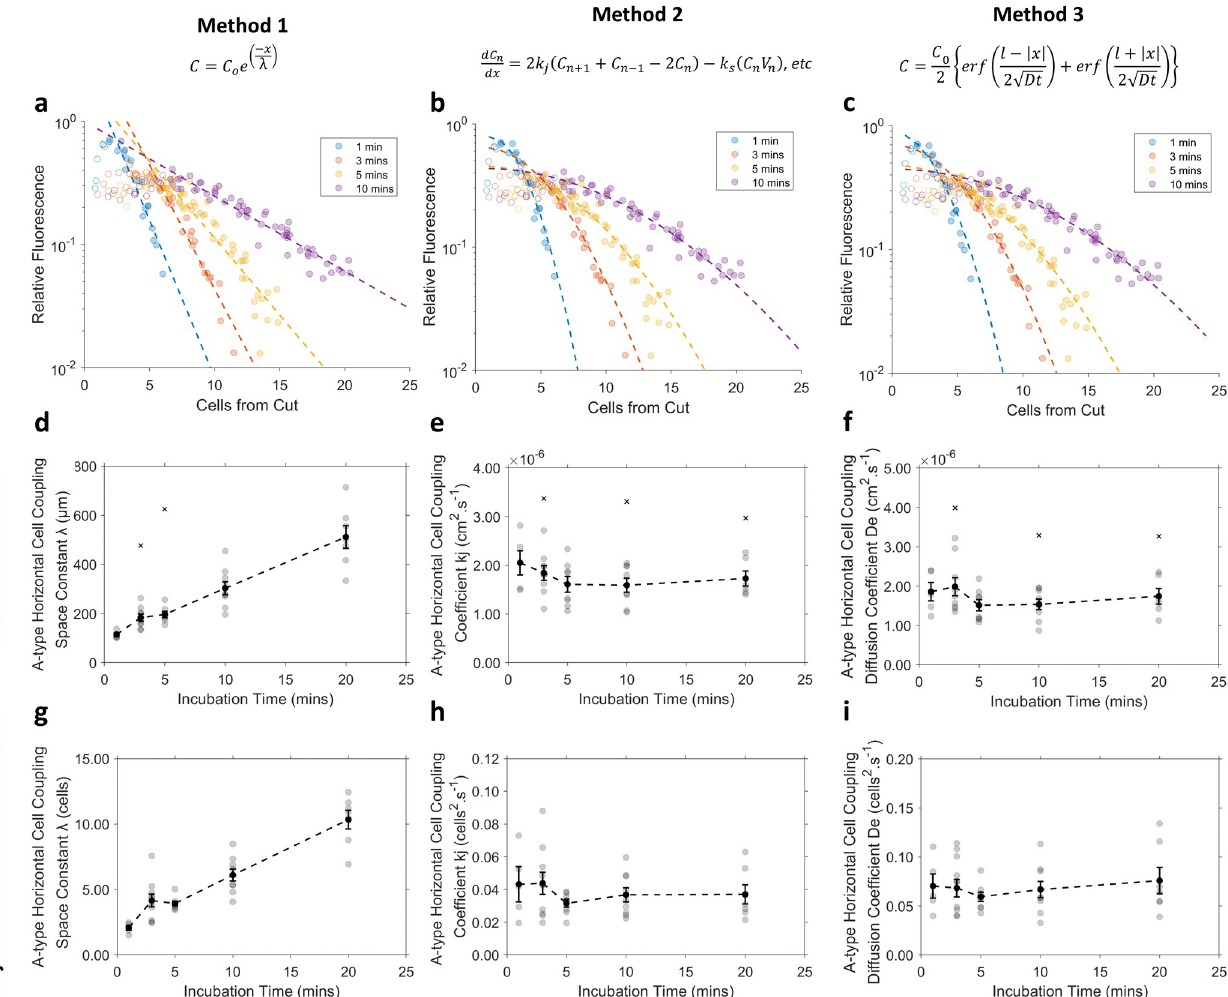
Fig 6. Comparison of three analytical techniques for assessing the extent of a-type horizontal (aHCs) cell coupling in cut-loaded Guinea pig retinas with increasing incubation times. Column 1 (a, d, g) contains cell fluorescence data analysed using Method 1. Column 2 (b, e, h) shows the same data analysed using Method 2 and column 3 (c, f, i) shows the same data analysed using Method 3. The first row (a, b, c) contains example fits for cell fluorescence data collected per each cell separation following four incubation times, fitted with (a) Eq (1), (b) Eq (6) and (c) Eq (9) corresponding to Methods 1, 2 and 3 respectively. Open markers indicate cells adjacent to the cut with reduced fluorescence. Row 2 (d, e, f) contains the mean ± SE (black marker, black error bars) and individual measurements (grey markers) for each measure of cell-coupling obtained via: (d) Method 1 (e) Method 2 and (f) Method 3. Row 3 (g, h, i) contains the mean ± SE (black marker, black error bars) and individual measurements (grey markers) for each measure of cell-coupling normalised to the mean cell-cell spacing between adjacent aHCs, obtained via: (g) Method 1 (h) Method 2 and (i) Method 3. Crosses indicate outliers defined as data points greater than 1.5 standard deviations from the mean and are not included in calculated